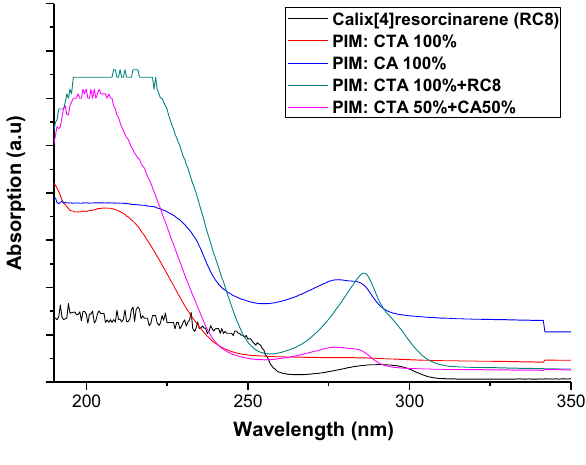
Fig. 6 UV–Vis spectra of developed PIMs Table 2 Thickness, porosity and water absorption capacity of the PIMs produced